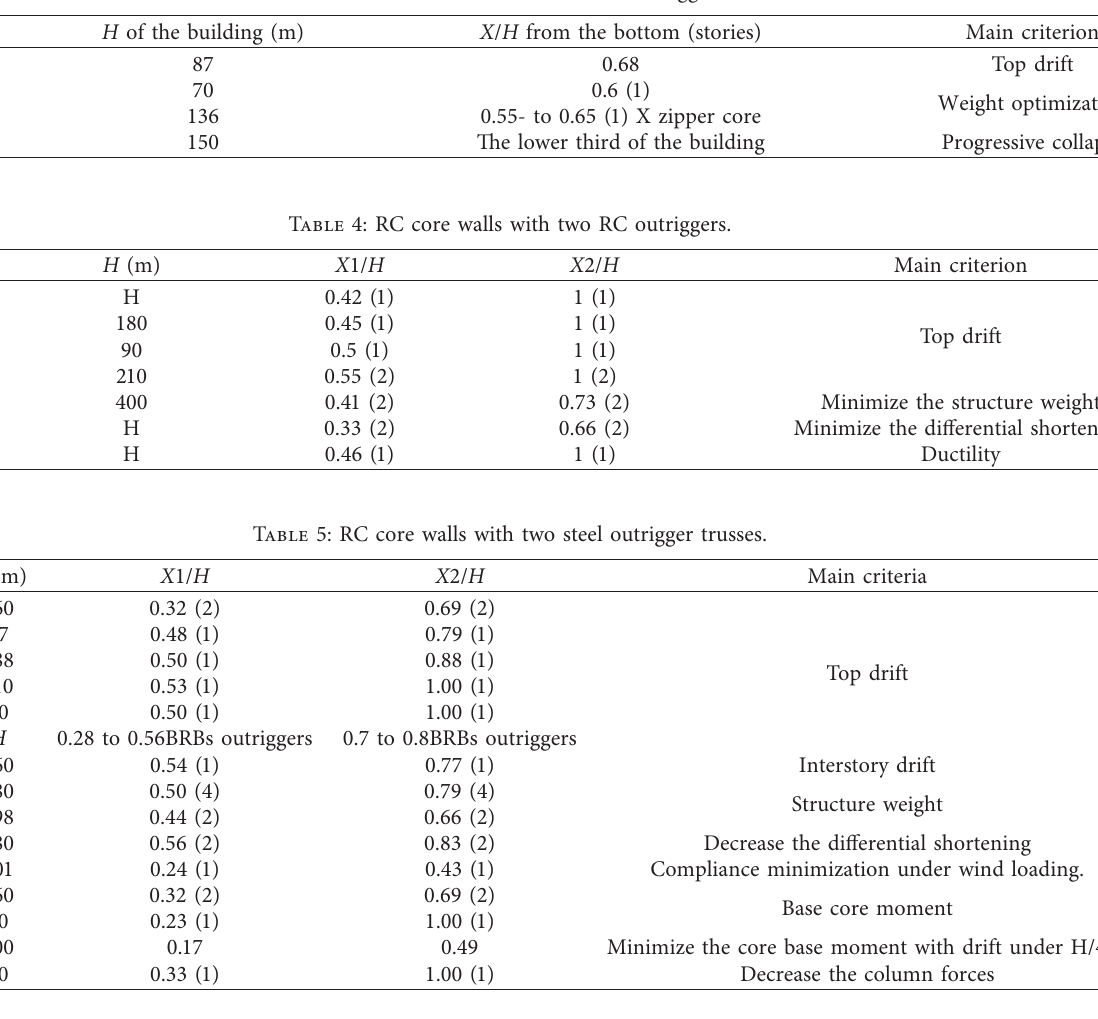
Table 3: Steel braced core with one steel outrigger truss.